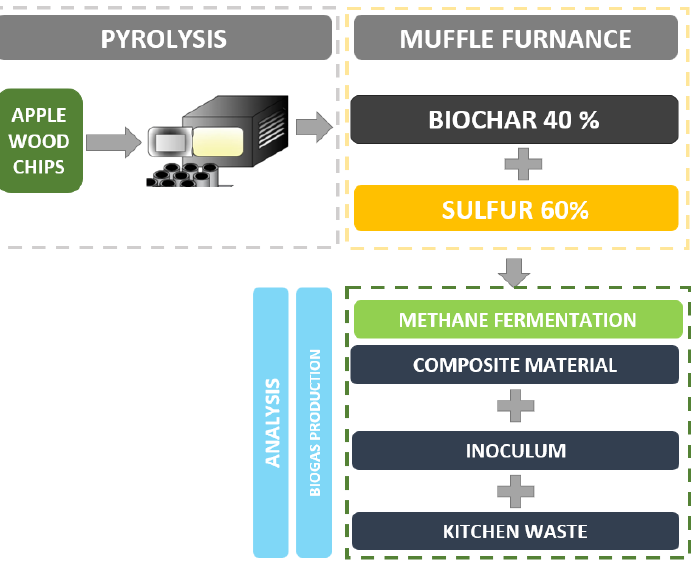
Figure 1. Procedure to produce biogas and SBC mixture to test the potential of biogas production.